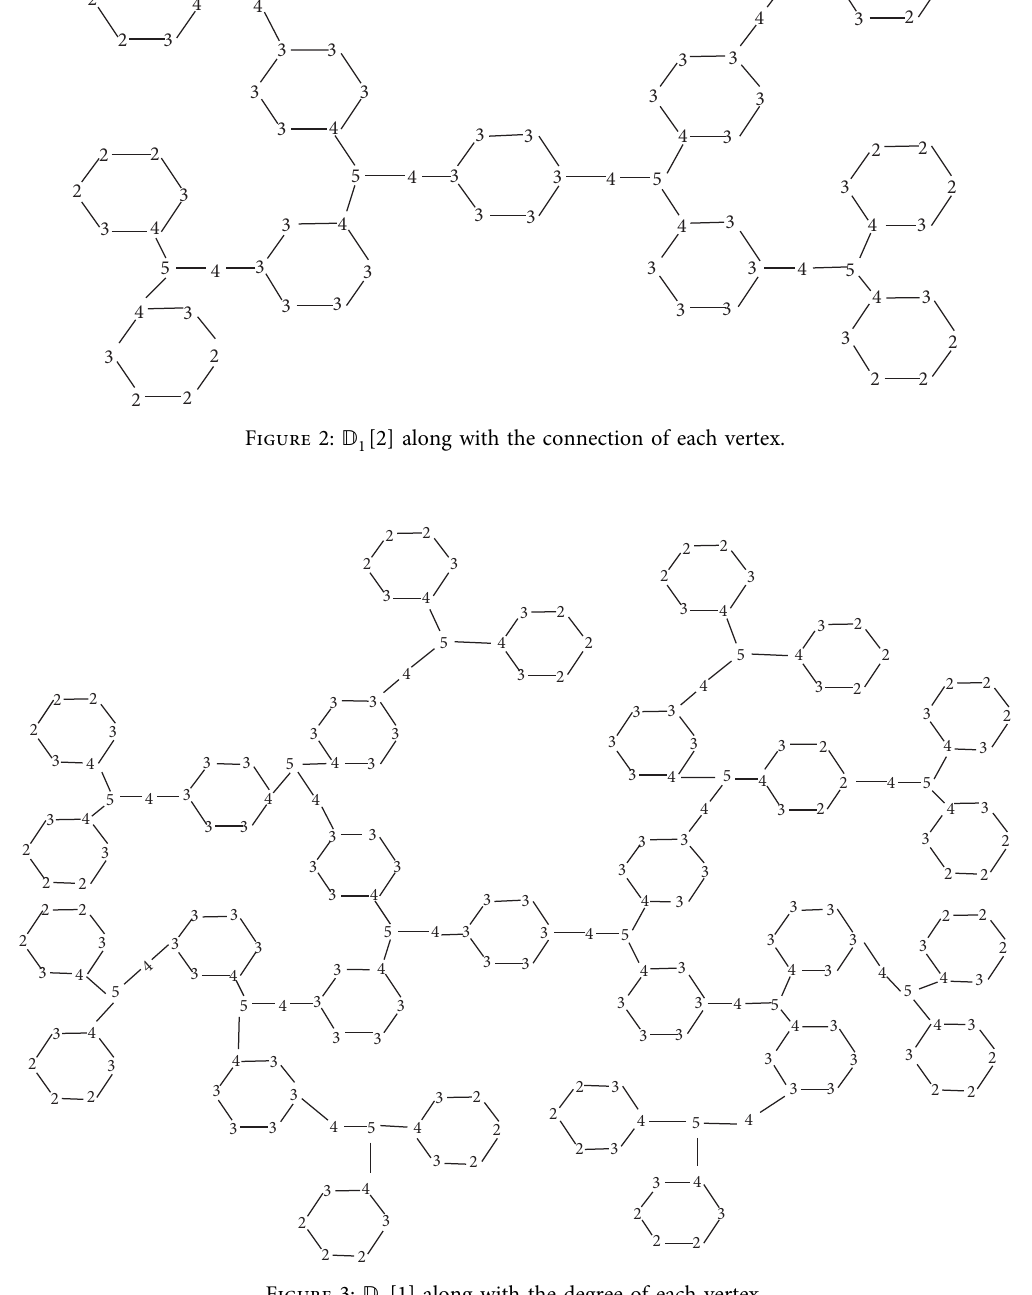
Figure 3: D [ 1 ] along with the degree of each 1